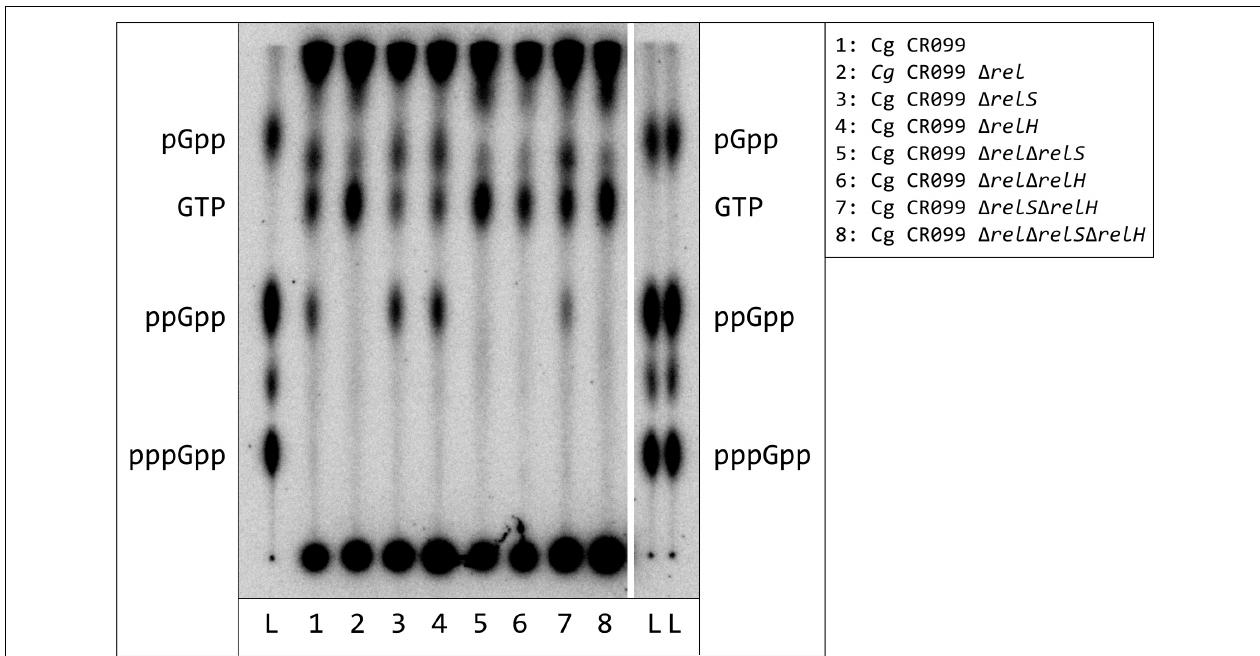
FIGURE 3 | Synthesis of hyperphosphorylated nucleotides in C. glutamicum strains with deletions of (p)ppGpp metabolism associated genes after exposure to total starvation. C. glutamicum cells were labeled in CGXII medium (low P), containing all proteinogenic amino acids (50 mg/L each), for 3 h with 54 µ Ci/ml [ 32 P]orthophosphate. The cultures were centrifuged and subsequently resuspended in starvation solution. All samples were further incubated for 30 min under constant conditions. For nucleotide extraction, the cell pellets from treated samples and the untreated controls were resuspended in 6 M formic acid, shock-frozen in liquid nitrogen and subjected to five freeze-thaw cycles. 1.5 µ L of the clarified supernatant were applied to PEI cellulose TLC-plates and developed in 1.5 M KH 2 PO 4 solution (pH 3.4). 32 P-labeled pGpp, ppGpp, and pppGpp standards were prepared enzymatically by RelS catalyzed pyrophosphorylation of GMP, GDP, and GTP using [ γ - 32